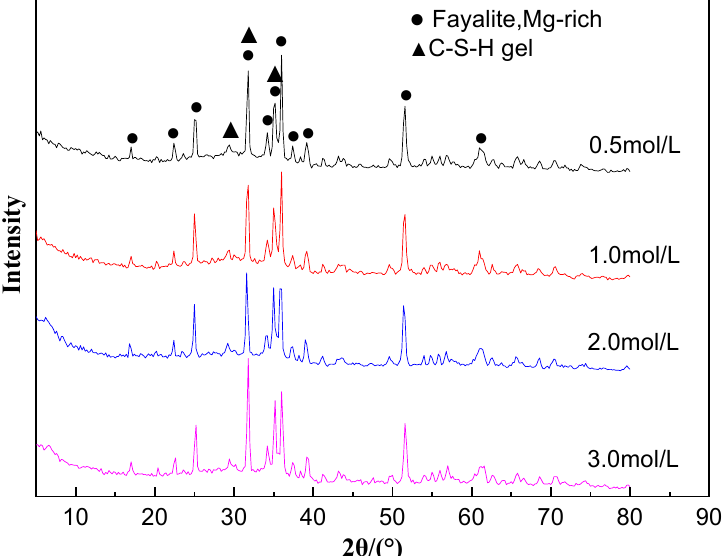
Figure 3. XRD patterns of CNS dissolved by different concentrations of sodium silicate